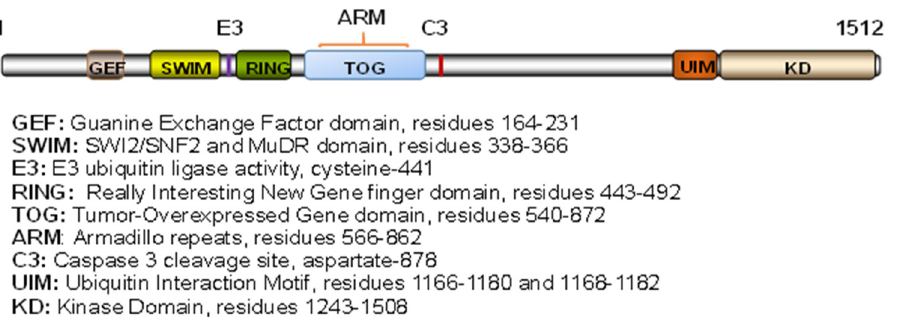
Figure 1. Schematic structure of MAP3K1. Illustration of the functional domains and the relative domain locations of human